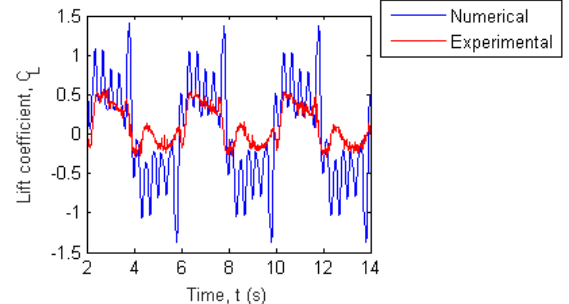
Fig. 8. Numerical and experimental results comparison of the time evolution of lift forces.